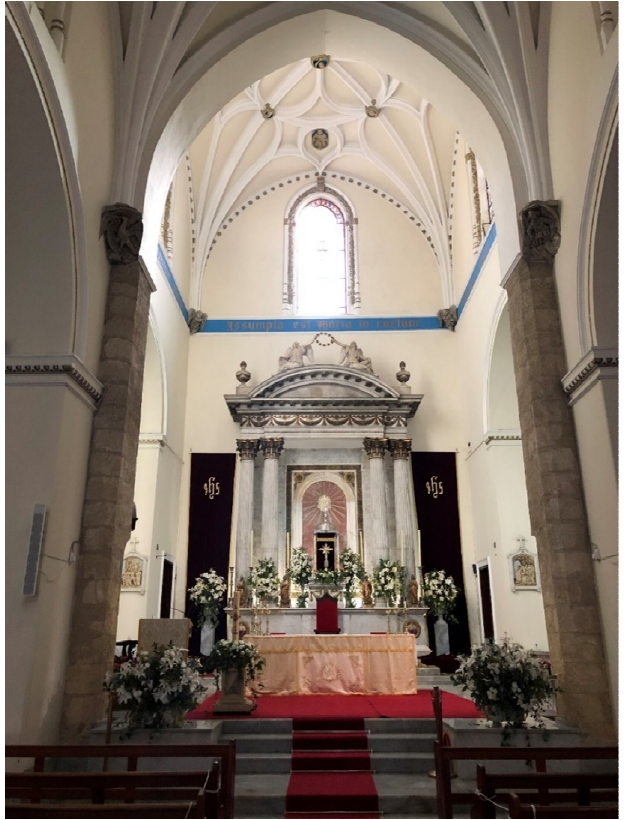
Figure 11. The high altar of the Cathedral of Saint Mary the Crowned, Gibraltar.